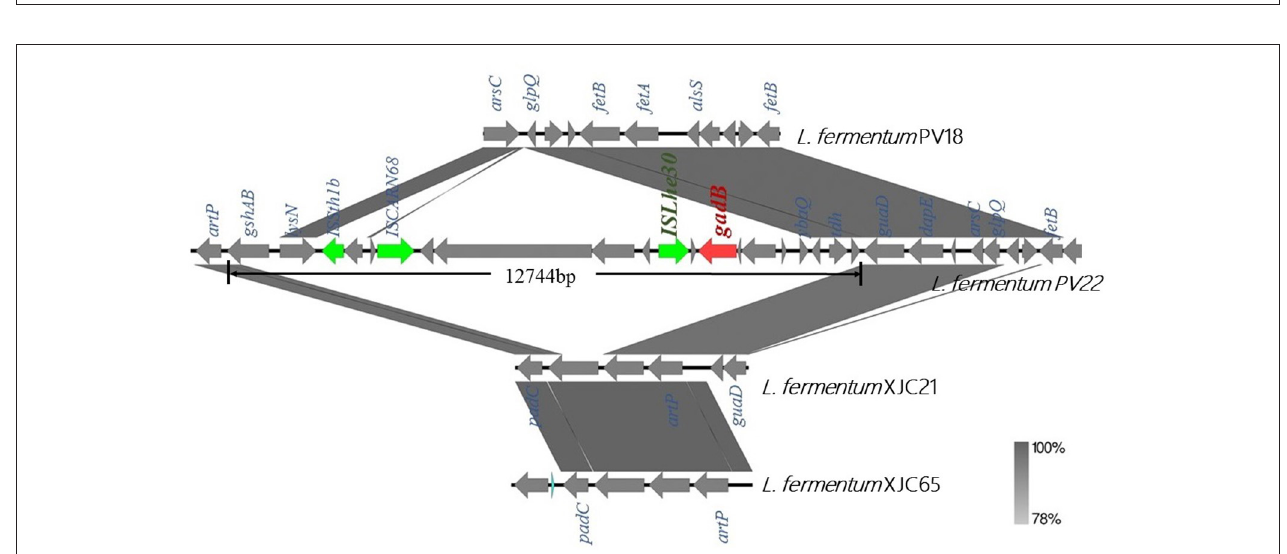
FIGURE 5 | Genome analysis of gadB -expressing Limosilactobacillus fermentum PV22. Comparison of linear sequences derived from L. fermentum PV22 with those from other isolated strains of L. fermentum , including healthy centenarian gut-derived strain L. fermentum PV18 and traditional homemade yogurt-derived strains L. fermentum XJC21 and XJC65. gadB (red arrow) is located on an insertion sequence of 12,744 bp. Boxed arrows represent the position and transcriptional direction of open reading frames (ORFs). ORFs encoding transposases are marked in green.